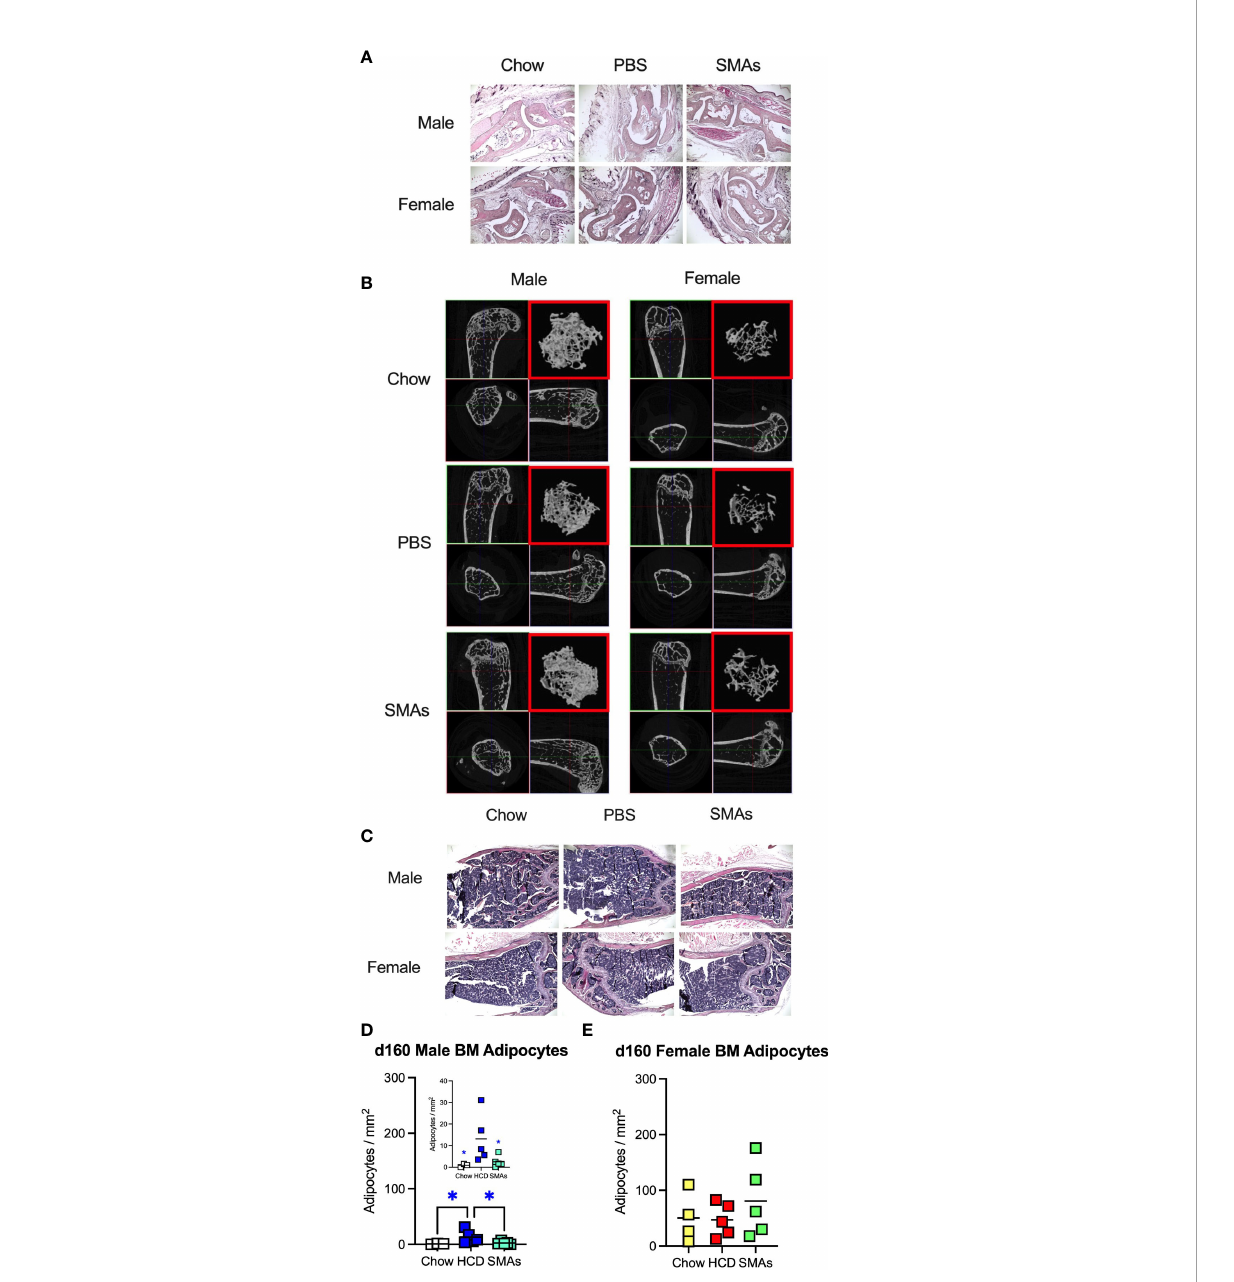
FIGURE 7 ES-62-based SMAs protect against disruption of the BM niche in male HCD-fed mice at d160, a time-point when substantial (obesity-accelerated) loss of trabecular bone structure is established. (A) Representative sections of H & E staining of paw joint sections (scale bar 1000 µm) are shown for the indicated groups of d160 male and female mice and where tissue damage was not signi fi cantly different across the groups. Scores: for male mice, Chow: 0.66 ± 0.19, n=4; PBS-HCD: 0.38 ± 0.10, n=6; SMAs-HCD: 0.50 ± 0.17, n=6; for female mice, Chow: 0.58 ± 0.16, n=4; PBS-HCD: 0.53 ± 0.17, n=5; SMAs-HCD: 0.33 ± 0.15, n=5. (B) MicroCT analysis offemurs from the indicated groups of d160 male and female mice was performed and representative 2D images of transverse sections through femurs illustrating the reference growth plate and the downstream area (~200 slices of pixel size 5 µm) of analysis of trabecular parameters (upper left and lower right boxes) are shown. Reconstruction of the image stack provided 3D images of the trabecular structure (red box) whilst cross-sectional analysis provides a 2D image of the cortical bone (lower left box). (C) Representative images of BM adipocytes (x10 magni fi cation, scale bars 400 µm) in male and female Chow-, HCD-PBS- and HCD-SMAs-fed mice at d160 are shown. (D, E) Quantitation is by Image J analysis where the mean group number/mm 2 ± SEM is determined from the mean values (of triplicate FoV values) of the individual mice (symbols) and the group means are indicated by the bars for male (D; insert shows expanded scale) and female (E) mice. Signi fi cant differences are indicated by blue*=p < 0.05 for male HCD-PBS v male Chow or male HCD-SMAs mice (D)